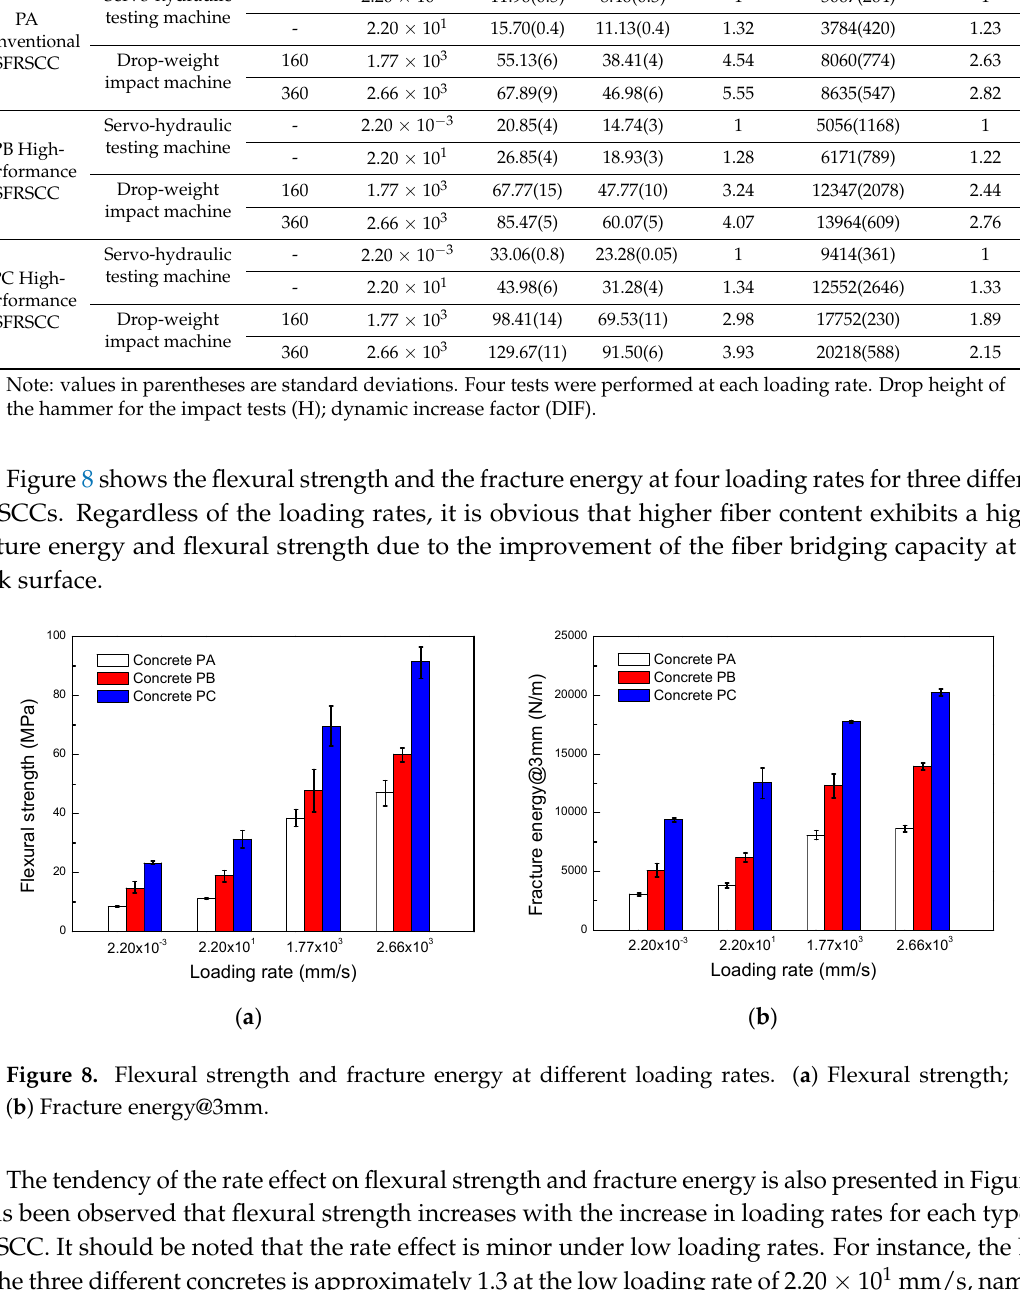
Table 4. Experimental results at different loading rates.